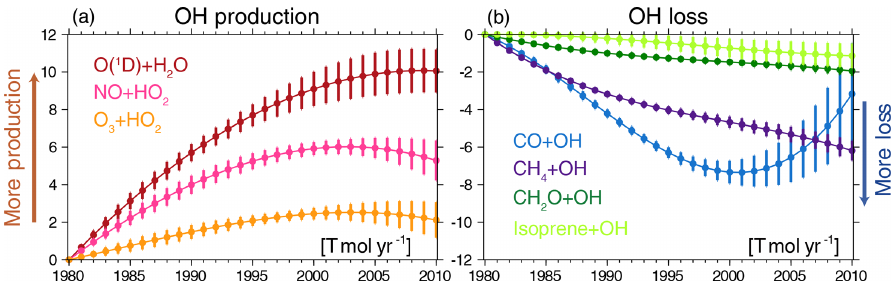
Figure 2. Annual total OH tendency (Tmolyr − 1 ) from chemical reactions with respect to the year 1980 with year-to-year variations removed. The positive and negative tendencies represent OH production (a) and loss processes (b) , respectively.